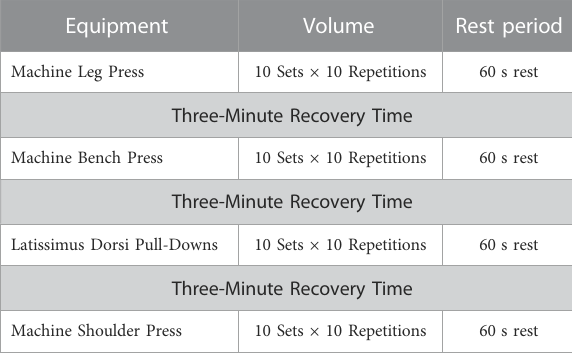
TABLE 1 German Volume Training (GVT)